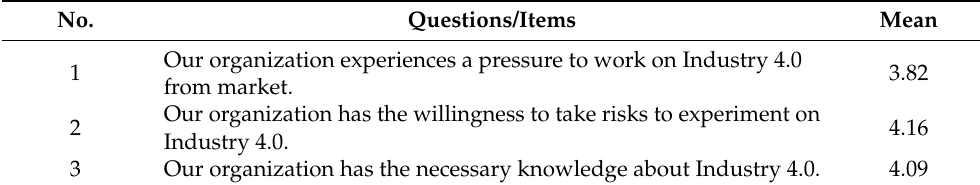
Table 2. Summary of Industry 4.0 readiness Table 2 . Summary of Industry 4.0 readiness measures.